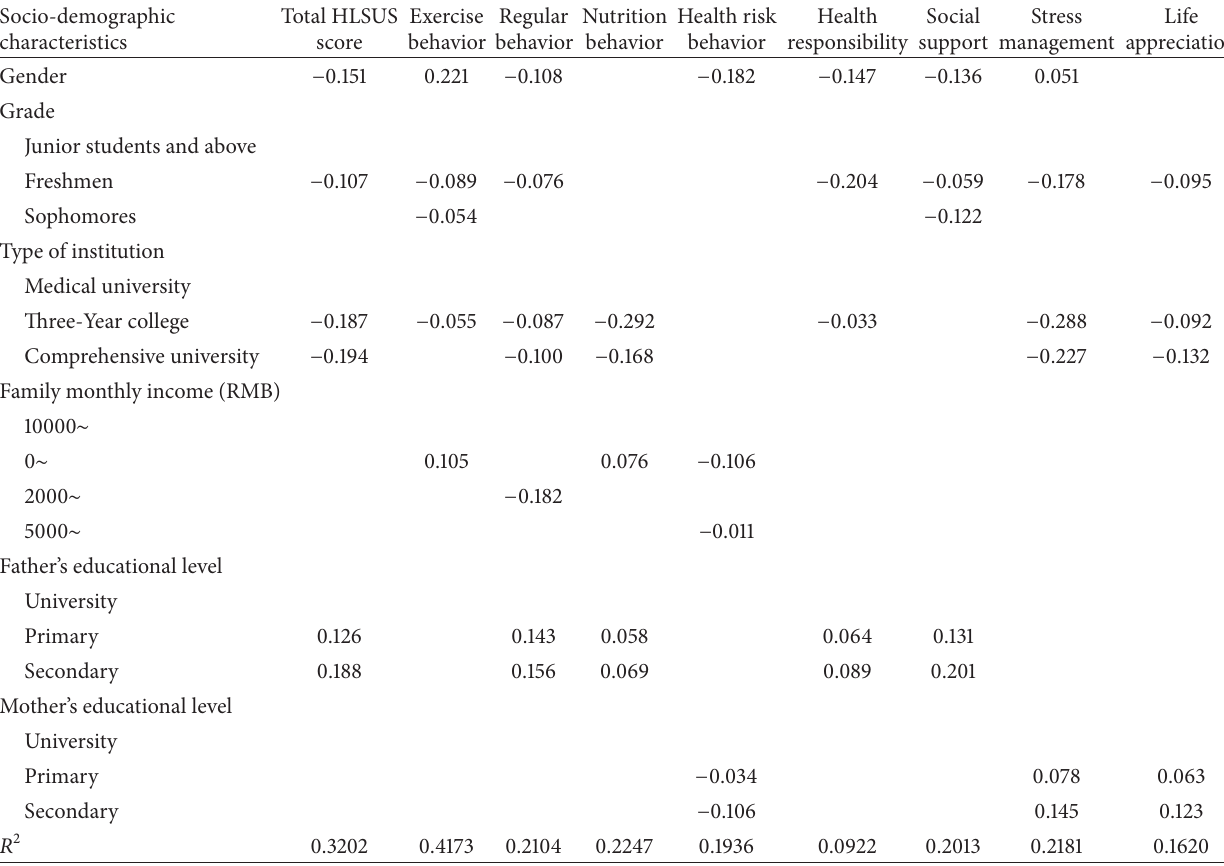
Table 4: Standardized regression coefficients of socio-demographic variables on healthy lifestyles for university students ( 𝑛 = 4908